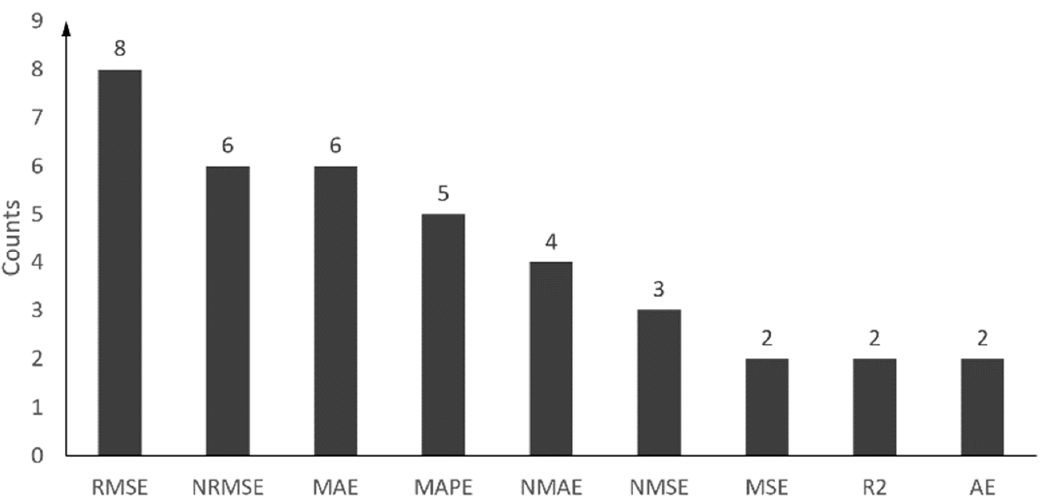
Figure 2. Statistical description of chosen evaluation criteria in prior research.